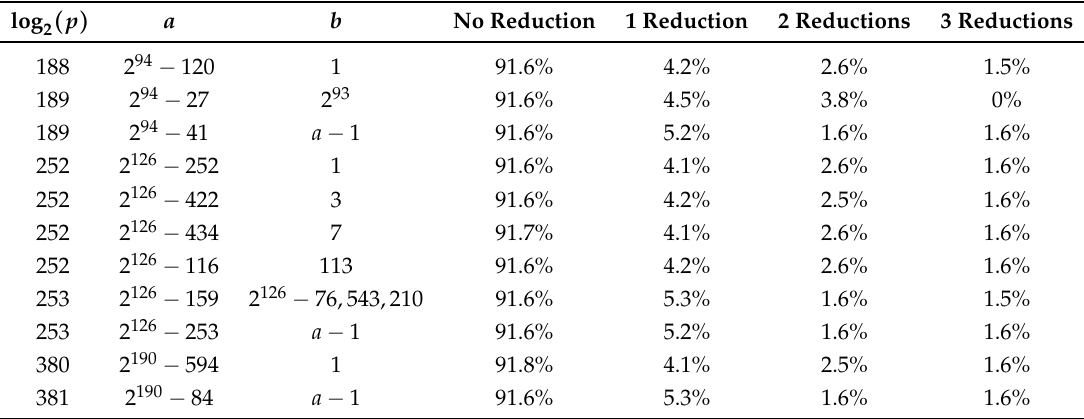
Table 2. Examples of primes of the form p = a 2 + b 2 suitable for ECC applications, and the percentage of the number of required offset reductions for 100 k